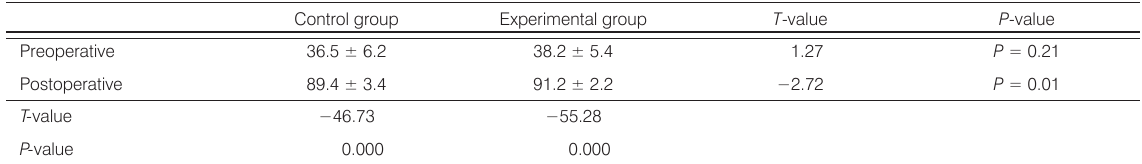
Table 1. Comparison of HSS scores between the two